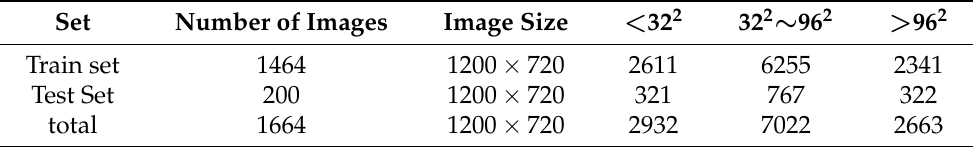
Table 2. WHUCS ship